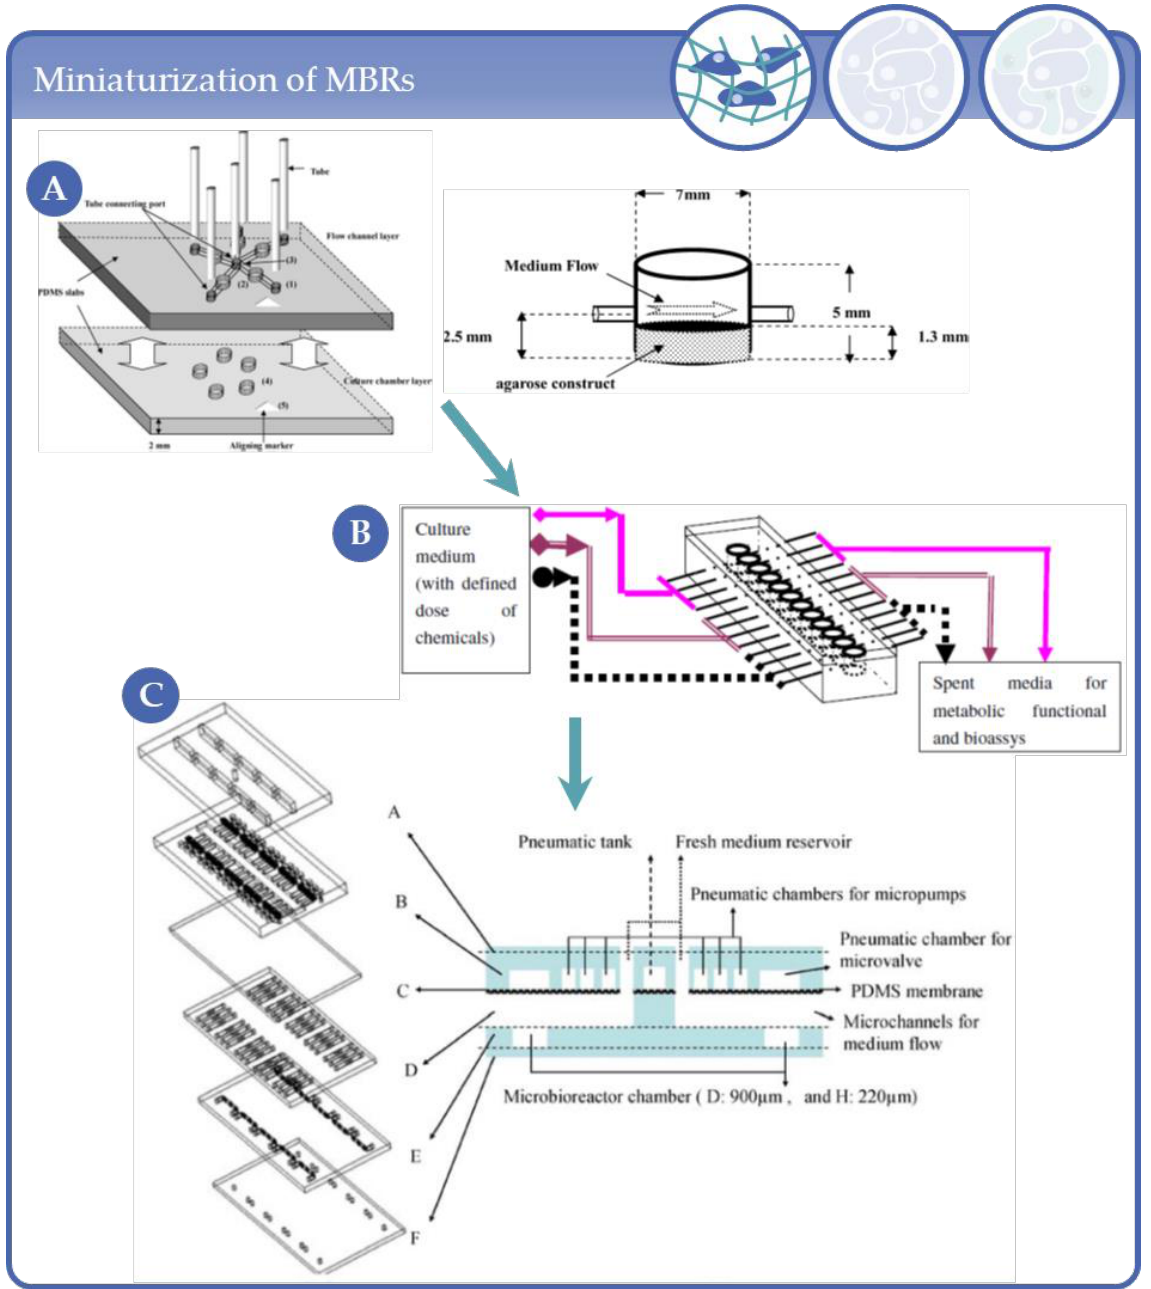
Figure 4. Steps in the development of miniaturized and parallelized microfluidic MBRs; Microfluidic platform with 5 MBRs. Reprinted with permission from [17] with permission from Springer Nature. ( B ) Schematic diagram showing the set-up of the parallel perfused bioreactor system with 12 micro-bioreactors. Each microbioreactor is individually supplied with culture medium through a multi-channel peristaltic pump. The effluents downstream can be collected individually. Reprinted from [18] with permission of Elsevier. ( C ) The assembly of the perfusion-based micro 3D cell culture platform including 30 MBRs and cross-sectional view of the laminate structure. Reprinted with permission from [19] from Springer Nature.